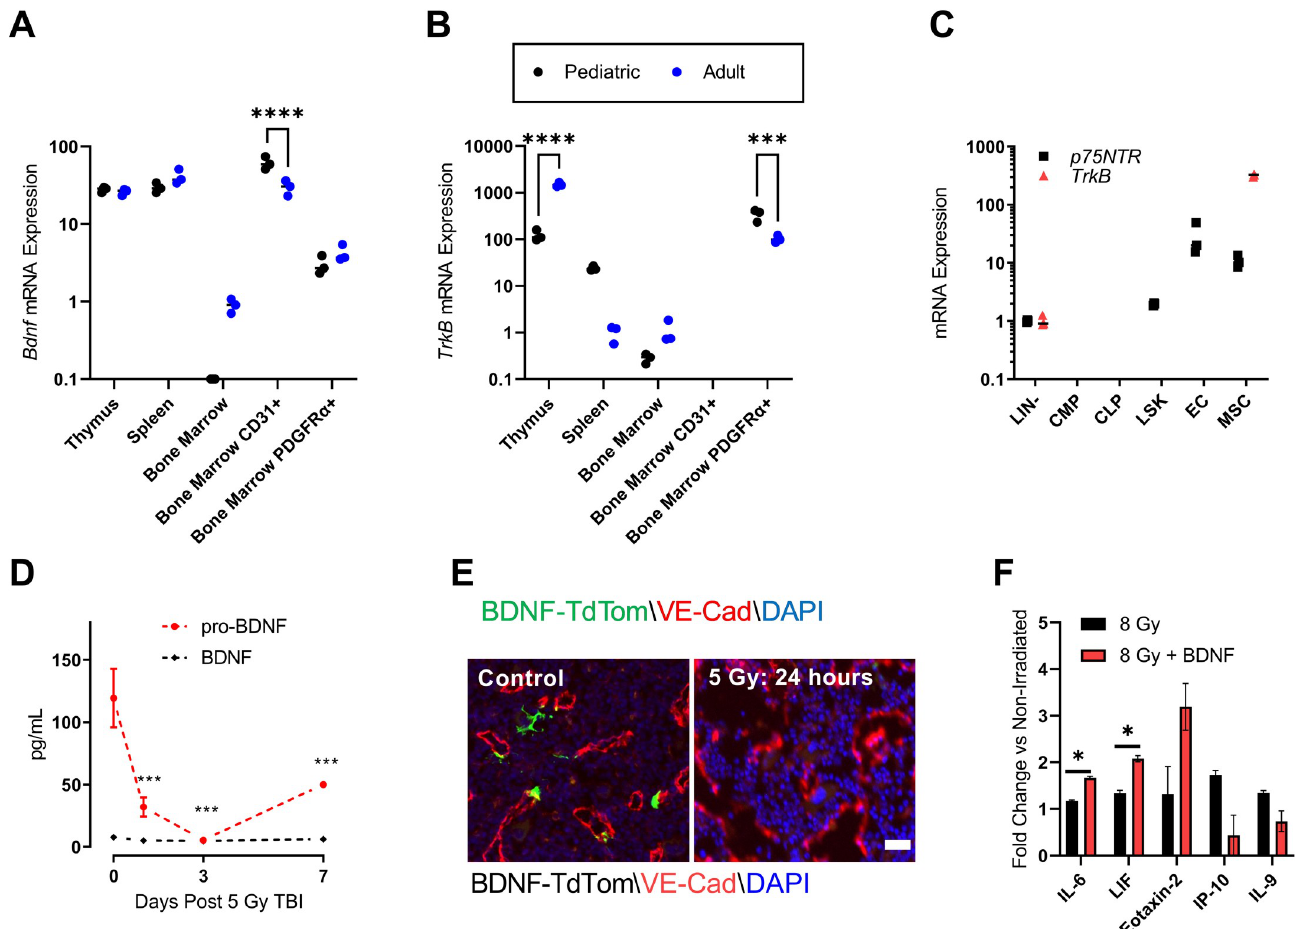
Fig 1. BDNF and TrkB expression in the bone marrow niche. (A) Bdnf mRNA expression in the thymus, spleen, bone marrow CD31+ endothelial cells (ECs), and bone marrow PDGFRa+ mesenchymal stromal cells (MSCs). (B) TrkB mRNA expression in the same populations. (C) p75NTR (NGFR) and TrkB mRNA expression in sorted hematopoietic stem and progenitor cell populations. Data are based on cells sorted from three mice per group. (D) ELISA analysis of BDNF and pro-BDNF protein concentration in the bone marrow supernatant following 5 Gy total body irradiation (TBI). n = 3 mice per timepoint. (E) Representative distribution of BDNF (green) in longitudinal femur sections labeled with VE-cadherin (red) and DAPI (blue) of non-irradiated control (left) and at 24 hours following 5 Gy TBI. Scale bar = 50 μ m. (F) Fold change in MSC cell culture supernatant levels of cytokines IL-6, LIF, Eotaxin-2, IP-10, and IL-9 following either 8 Gy (black bar) or 8 Gy + 100 ng/ml BDNF (red bar). Fold change is relative to non-irradiated control MSCs. n = 3 replicates per treatment. Significance was determined using multiple t-tests with Bonferroni correction. Shown are mean values +/- SEM. � P < .05, ��� P < .001, ���� P < .0001.